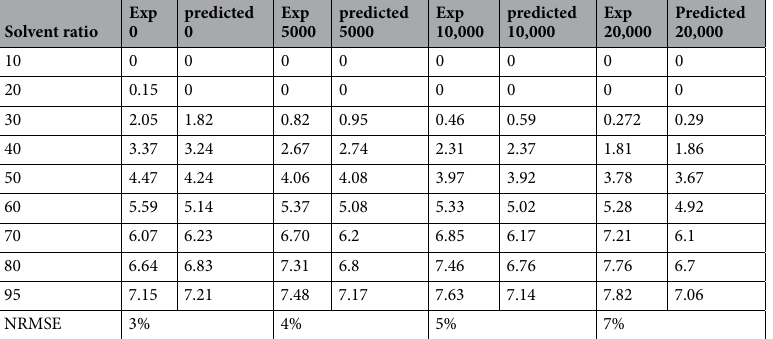
Table 7. Comparison of experimental and predicted asphaltene precipitation—Crude oil sample C (NRMSE =